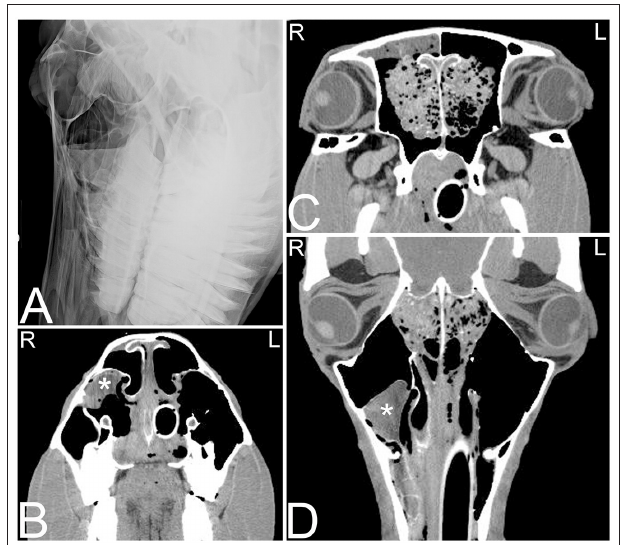
FIGURE 10 | Sinus cyst and ethmoid hemorrhage. Radiographic and computed tomography images of the caudal aspect of the head of an 11-year-old Quarter horse with a history of ∼ 1 year of unilateral mucoid nasal discharge. In the oblique radiographic view highlighting the right maxillary sinus area (A) , horizontal fluid levels are noted in the rostral and caudal right maxillary sinuses. The rostral aspect of the ethmoid turbinates is incompletely identified. In the transverse CT images at the level of the rostral nasal cavity (B) a thin walled, indistinct, heterogeneously contrast enhancing structure (marked by white asterisk) is noted in the dorsolateral aspect of the right maxillary sinus. In the transverse (C) and dorsal (D) CT images a heterogeneous contrast enhancement of the right ethmoid area with an increase in soft tissue attenuating material is noted. Additionally, a small amount of fluid attenuating material is noted in the right rostral and caudal maxillary and frontal sinuses. Histopathology of tissue obtained by biopsy during a sinoscopy from the right rostral conchal lesion suggested a sinus cyst with chronic sinusitis. The bilateral lesion of the ethmoid area was thought to be secondary to hemorrhage caused during intubation for anesthesia during the CT study. L, left; R,